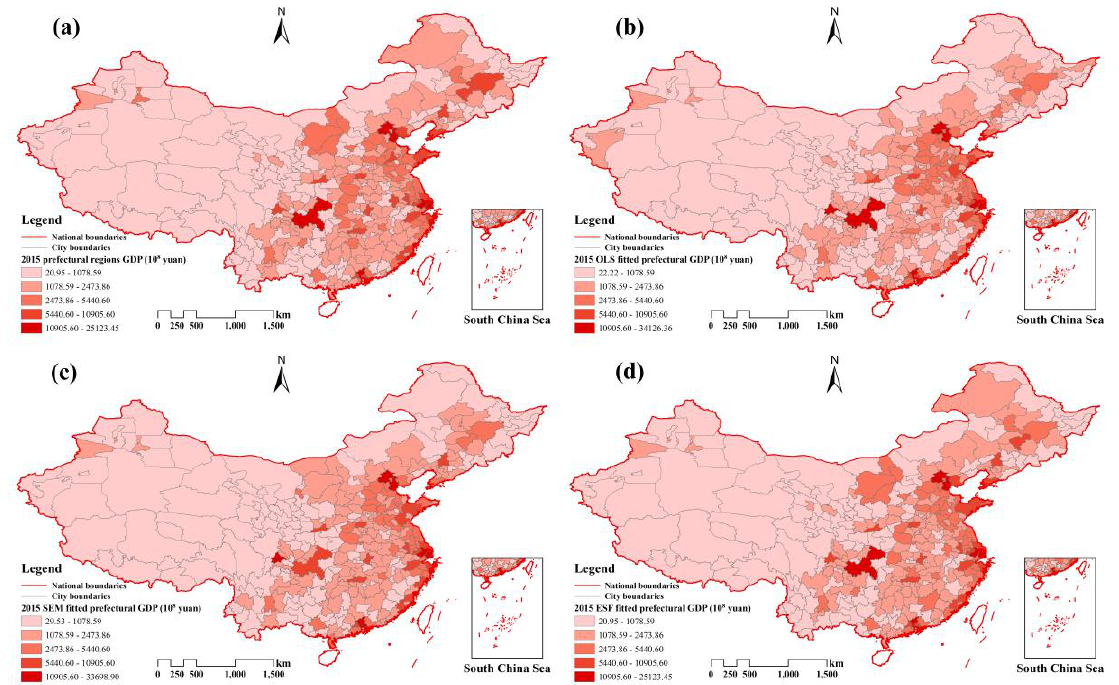
Figure 4. China prefecture GDP map in 2015: ( a ) original GDP distribution. ( b ) OLS fitted GDP distribution. ( c ) SEM fitted GDP distribution. ( d ) ESF regression fitted GDP distribution.